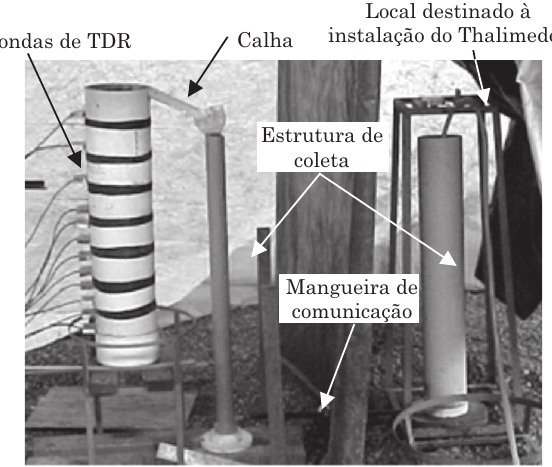
Figura 3. Disposição da coluna de PVC e da estrutura de coleta, durante o